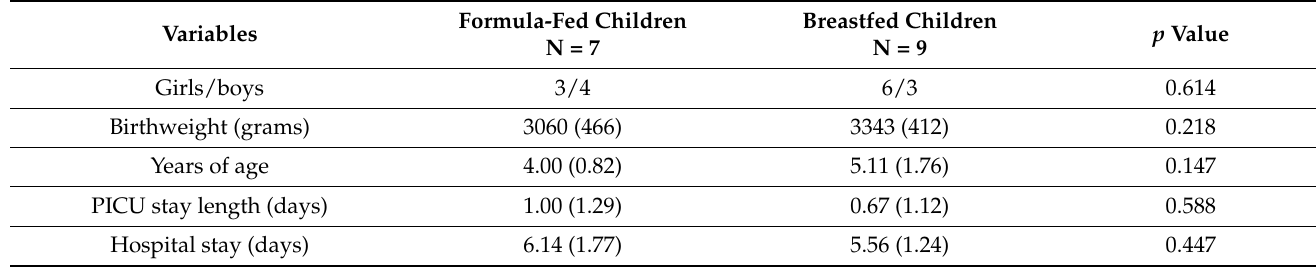
Table 2. Clinical characteristics of never and ever breastfed